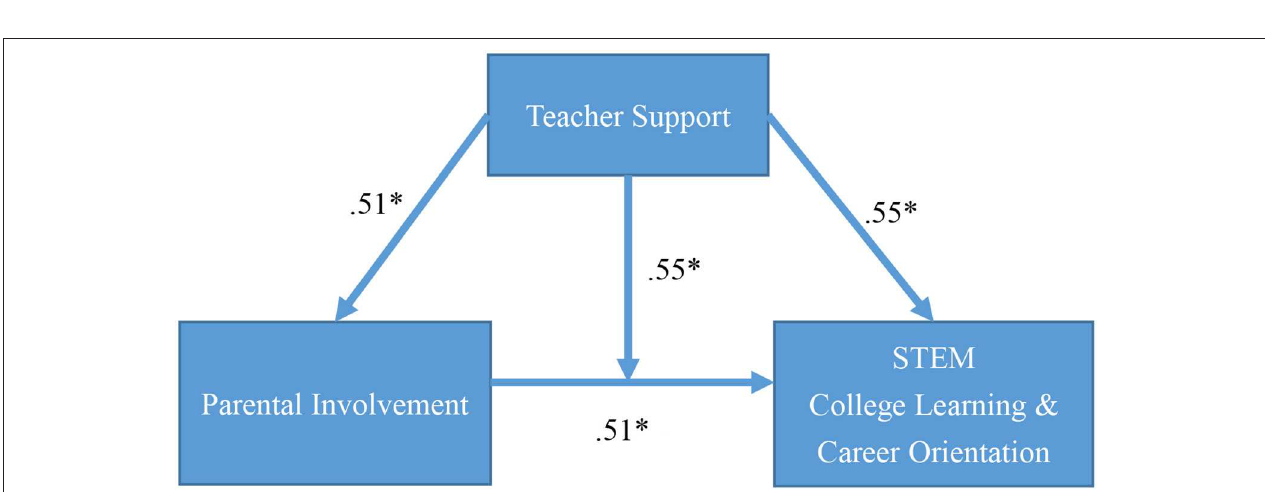
FIGURE 2 | The relationships between teacher support, parental involvement, and STEM college learning and career orientation by using a moderator analysis. * p <